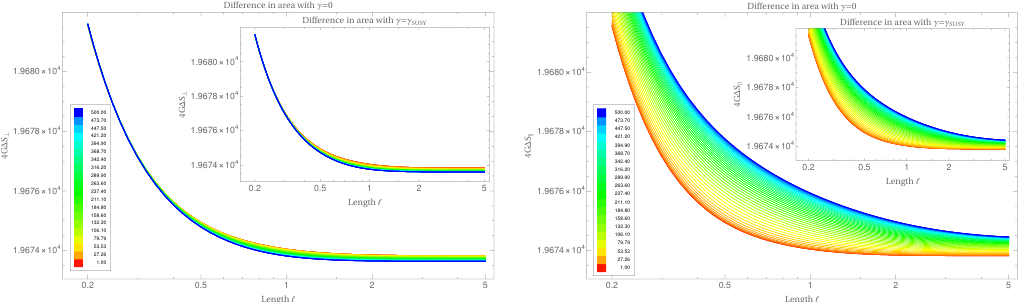
Figure 25 . Difference in the area between two possible embeddings ∆ S Left: transverse strips ∆ S ⊥ . Right: parallel strips ∆ S . In both images the inset graphic shows the same information || with γ = γ SUSY . The differences are displayed as a function of length scale ‘ at fixed µ/T = 5 for B/T 2 varying from B/T 2 = 1 . 00 to B/T 2 = 500 . 00